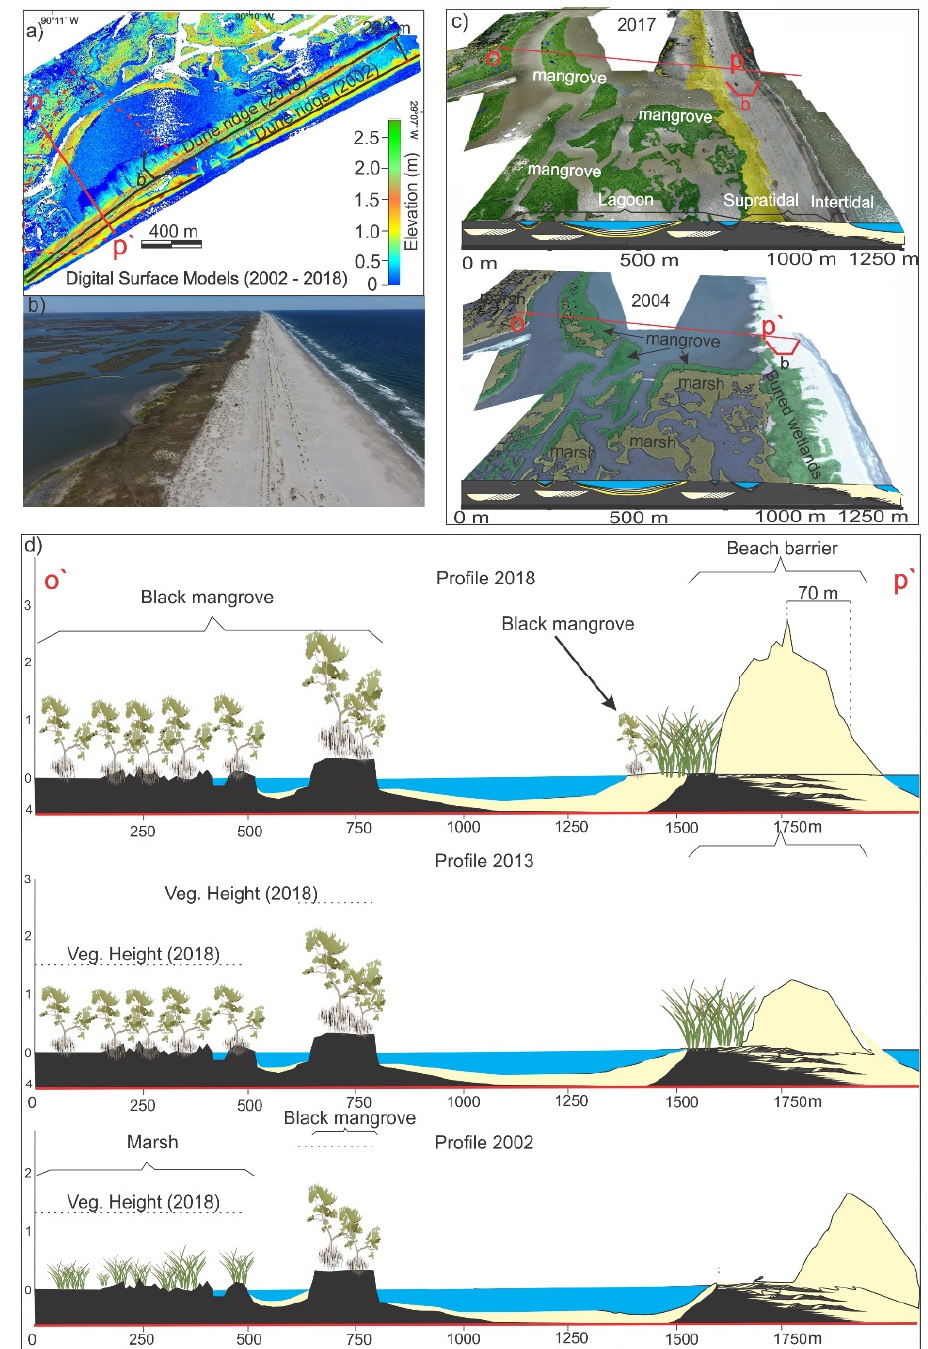
Figure 7. ( a ) Spatial-temporal analysis based on Lidar data (2002 and 2018), ( b ) ground photo of the wetlands in contact with the beach barrier, ( c ) mangrove expansion and coastal retreat evidenced by satellite (2004) and drone (2017) image, ( d ) planialtimetric cross-shore profile o`–p` showing the landward dune migration, an increase of dune crest height, and the replacement of Spartina by black mangrove in 2002, 2013 and 2018. Margin of error is ± 0.15 m (vertical) and 1 m